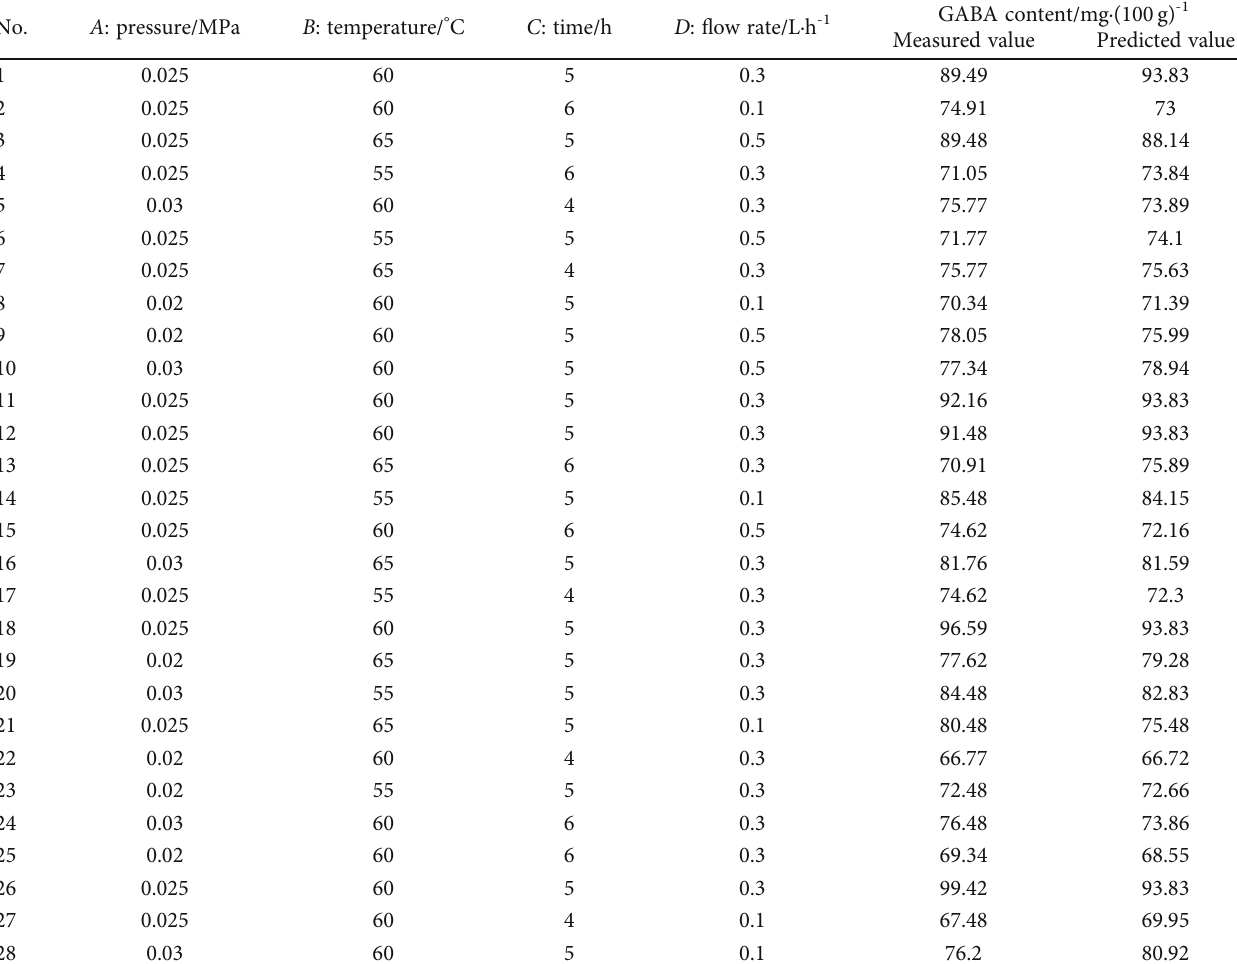
Table 3: Response and face analysis scheme and